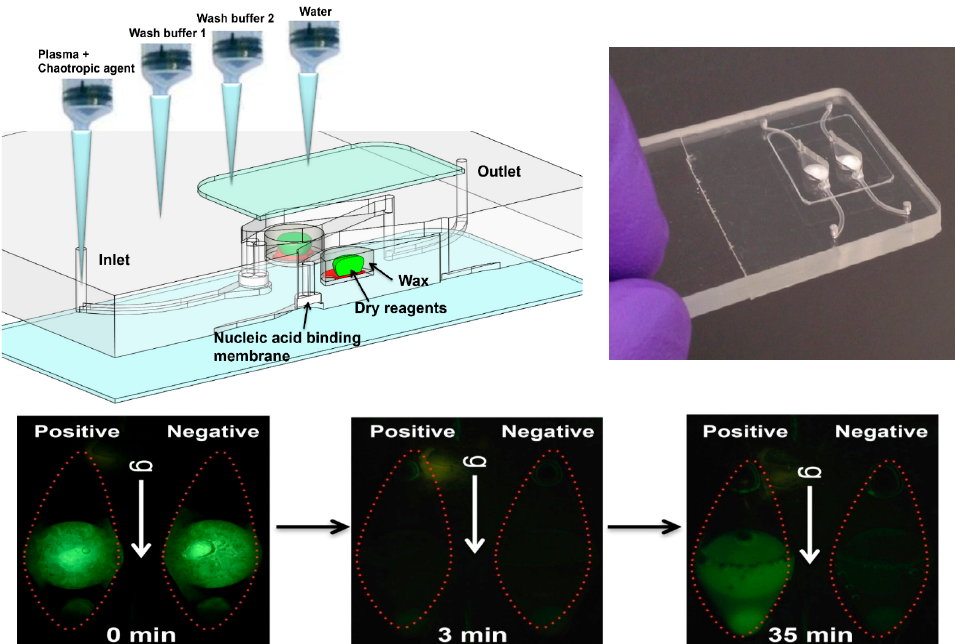
Figure 4. Chip with pre-stored, paraffin-encapsulated, lyophilized amplification reagents (polymerase, primers, nucleotides, magnesium and buffer components, reporter dyes, e.g., Eva Green™ DNA-intercalating fluorescent dye, and enhancers such as betaine and BSA). Top left: CAD (computer-aided design) drawing showing cross-section of chamber in forefront and second chamber (including inlet and outlet channels). Chips arrayed with ten or more such parallel chambers are feasible, allowing multiplex testing, or separate chambers for various controls and calibration. Chip is operated with a succession of pipetting steps to add sample (e.g., plasma mixed with chaotropic lysing/binding agent), followed by one or two wash steps, and backfilling the chamber with water; Top right: Photo of chip; Bottom: Series of top-view photographs of the chips showing fluorescence from two chambers at three stages of amplification: positive (left chamber) and no template negative control (right chamber). Initial green fluorescence (0 min) is due to fluorescence and reflection from solid wax. At 3 min, no signal. At 35 min, positive chamber shows fluorescence while negative chamber remains dark. From [60].